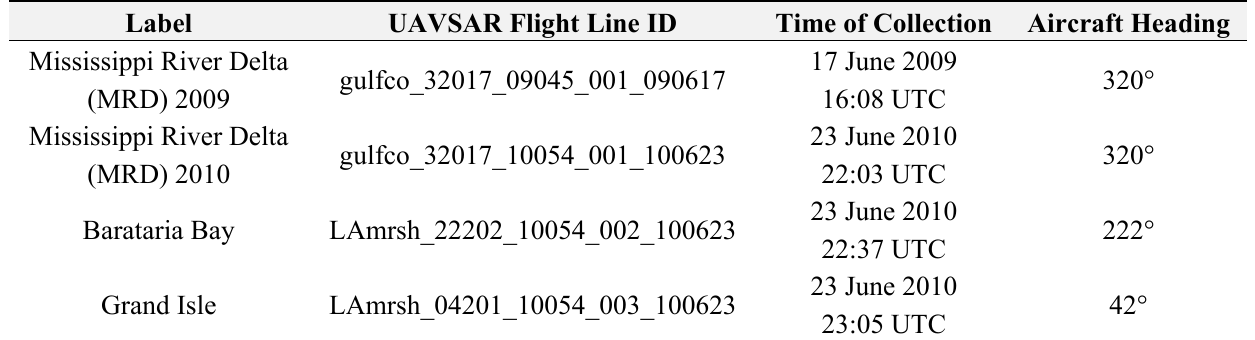
Table 1. Reference data for UAVSAR collections of Barataria Bay, Louisiana (Figure 1).